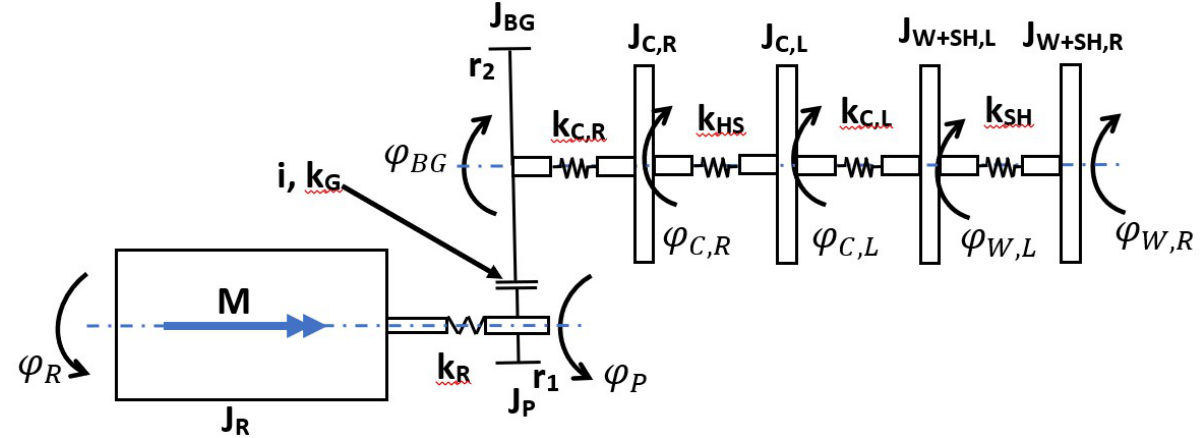
Figure 11. Schematic torsion